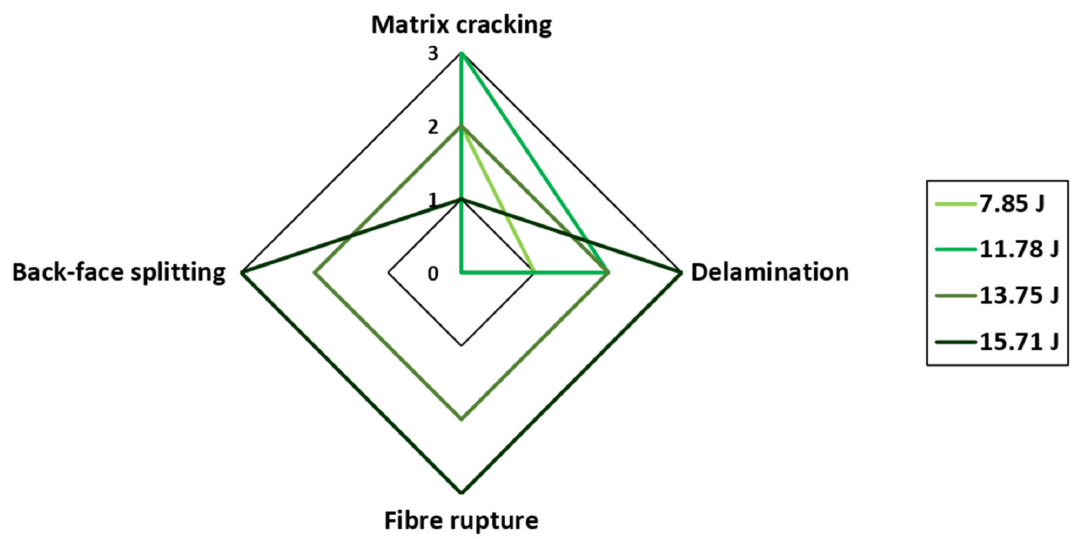
Figure 11. Failure modes of a composite specimen for four impact energies: 7.85, 11.78, 13.75 and 15.71 J. The scale of 0–3 represents the degree of failure (0 represents no failure mode observed and 3 represents complete